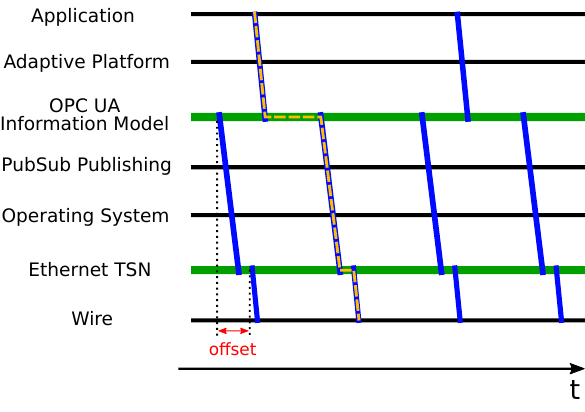
Figure 15. Information propagation through system